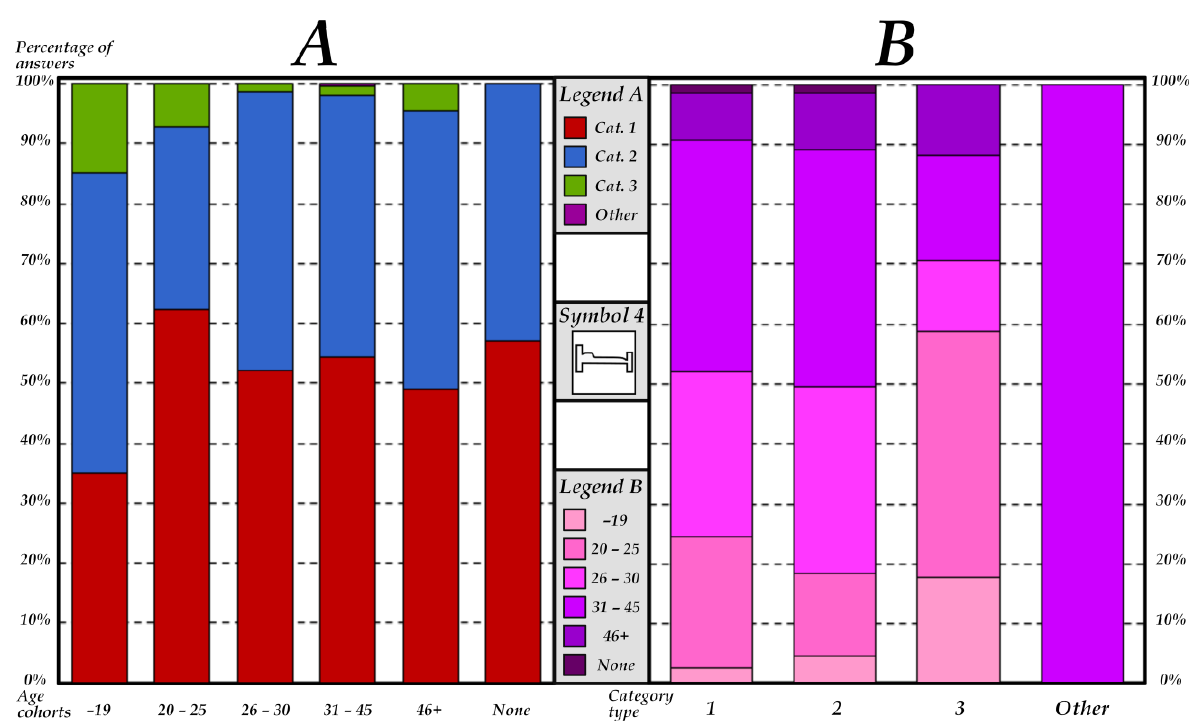
Figure 4. Cumulative charts presenting a percentage of individual categories of symbol 4 interpre- tation, divided according to age ( A ) and including individual age groups, divided according to interpretation category ( B ).